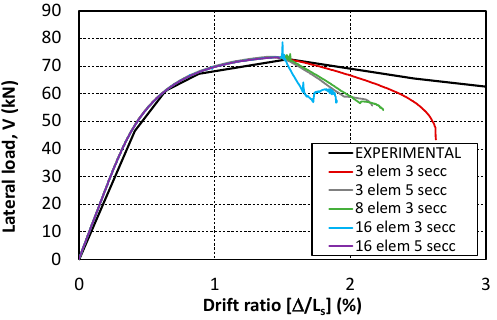
Figure 3. In fl uence of fi nite element size and number of integration sections.